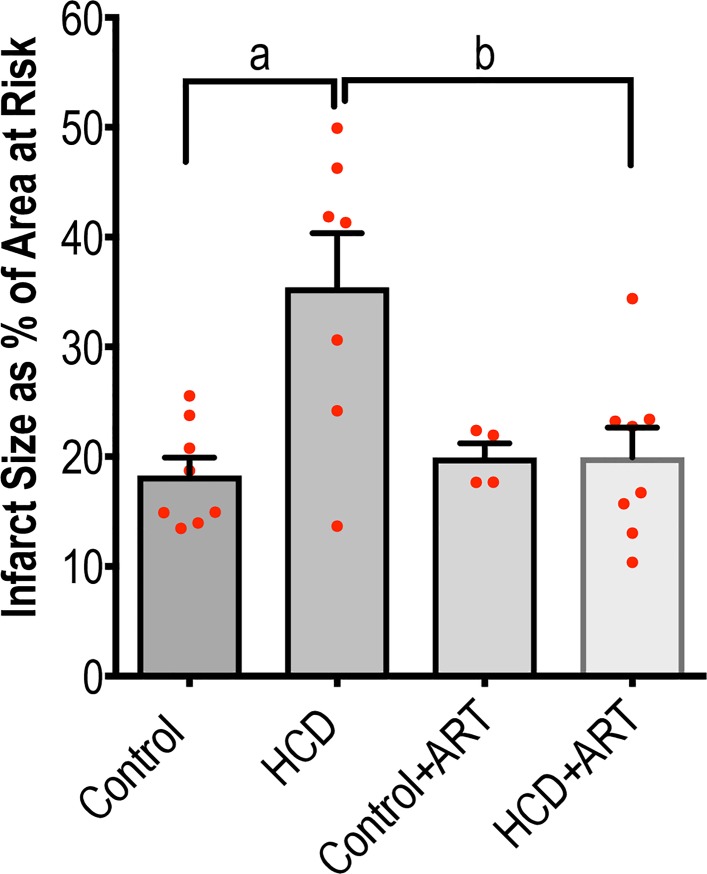
IS expressed as percentage of the area at risk.Control: 18.26 ± 1.66; HCD: 35.40 ± 4.95; Control+ART: 19.91 ± 1.30; HCD+ART: 19.95 ± 2.70. Control, n = 8; HCD, n = 7; Control+ART, n = 4; HCD+ART, n = 8. ap < 0.05, bp < 0.05. Data analysed by 1-way ANOVA (followed by Bonferroni multiple comparison).